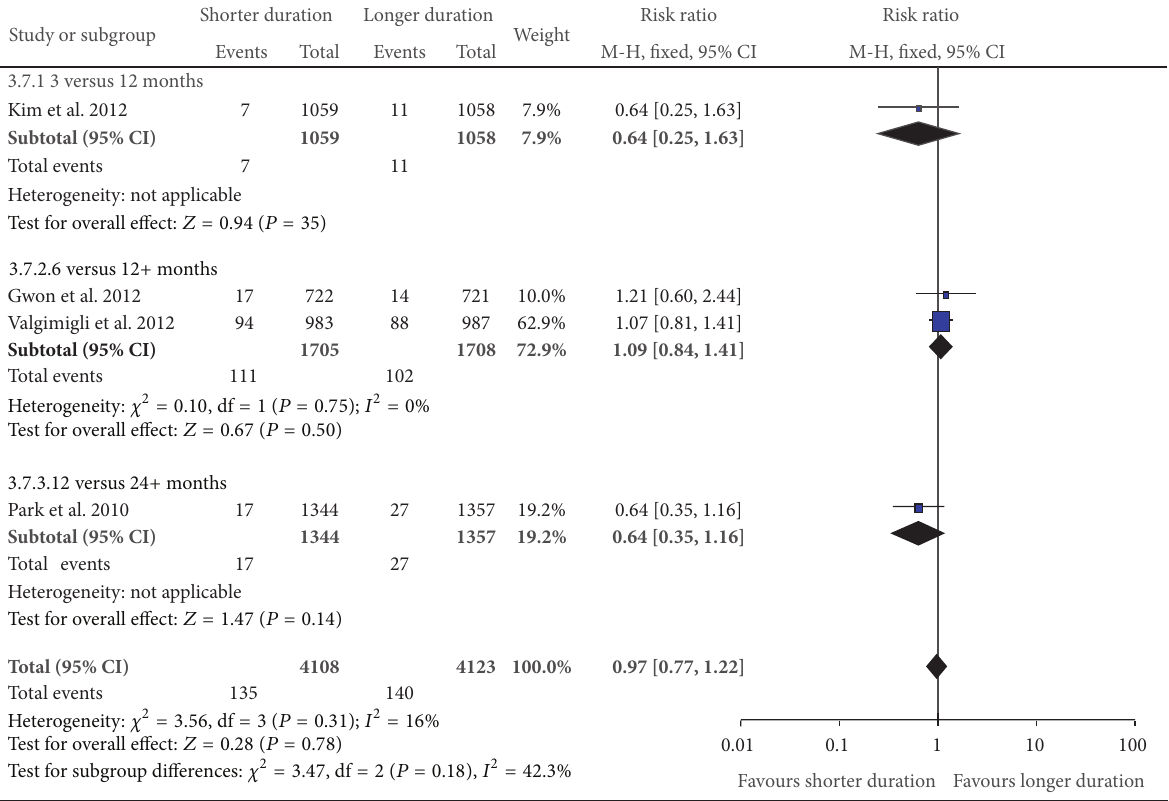
Figure 2: Risk of composite endpoint of death and myocardial